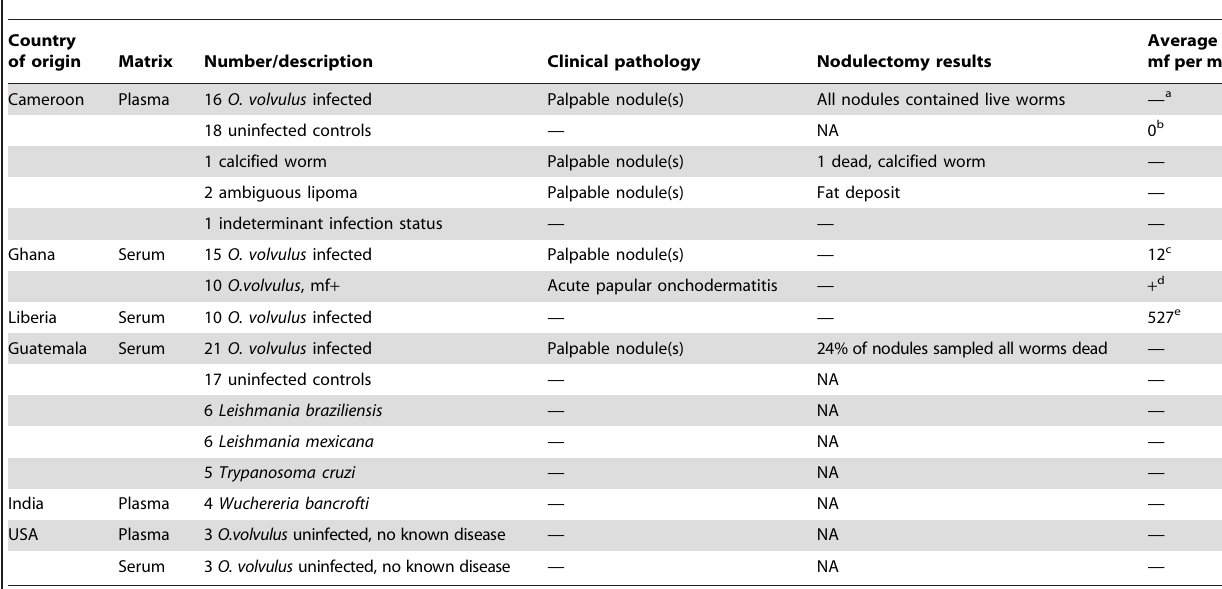
Table 1. Summary of samples analyzed in this study.